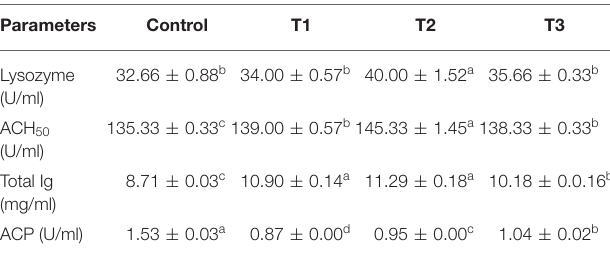
TABLE 5 | Serum immunological parameters of rainbow trout fed diets incorporated with different levels of zero (Control), 0.5% (T1), 1% (T2) and 2% (T3) of a mixture of herbs ( Mentha longifolia , Thymus carmanicus , Trachyspermum copticum ) for 45